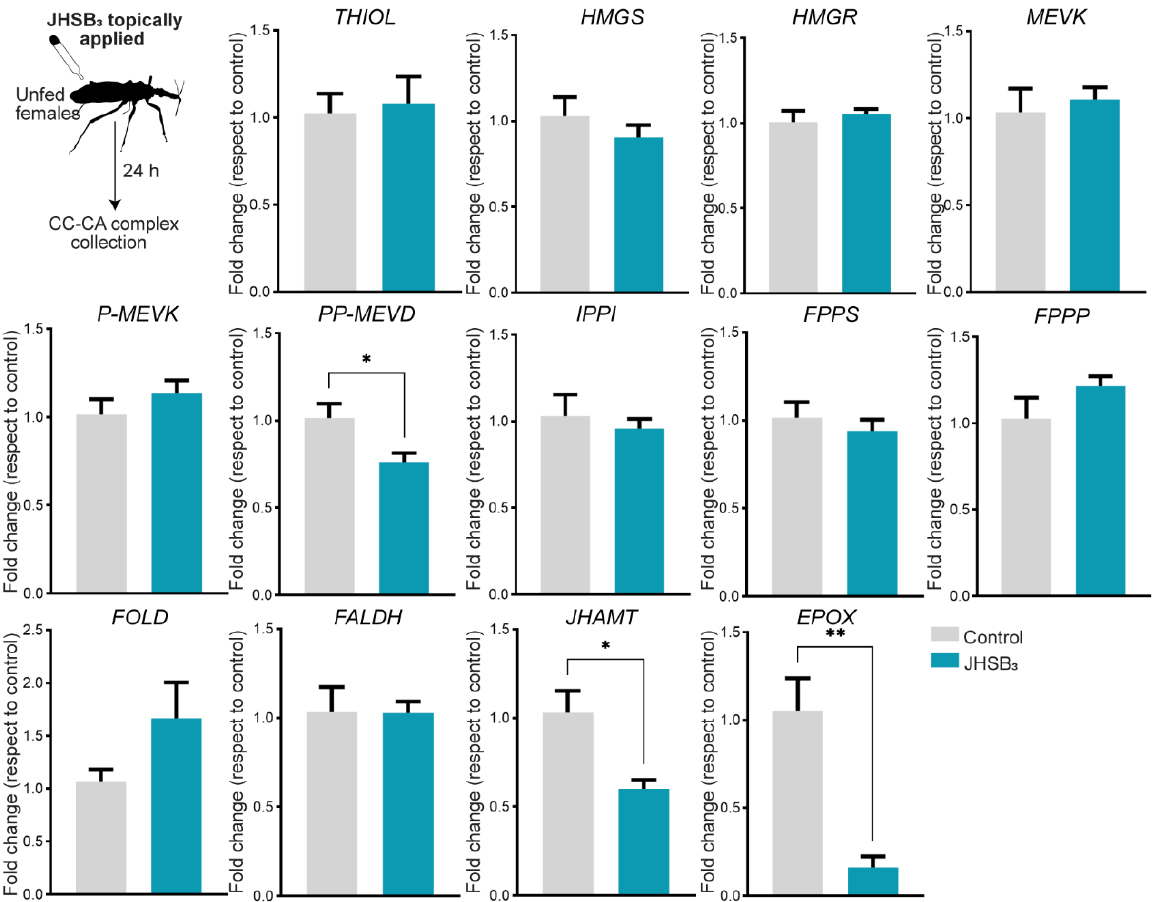
Figure 5. Effect of JHSB 3 on its own synthesis. Newly emerged adult females were treated with exogenous JHSB 3 (50 pg diluted in acetone), and 24 h later, transcript levels of JHSB 3 biosynthetic enzymes were analyzed using RT-qPCR and analyzed by the 2 −ΔΔ Ct method. The y axes represent the fold change in expression relative to control (insect treated with acetone, gray column, value ~1) obtained via geometric averaging using Rp49 and actin as reference genes. The results are shown as the mean ± SEM of n = 5, where each n represents a pool of CC-CA complexes from 3 insects. * p < 0.05; ** p < 0.01; (Student’s t -test).